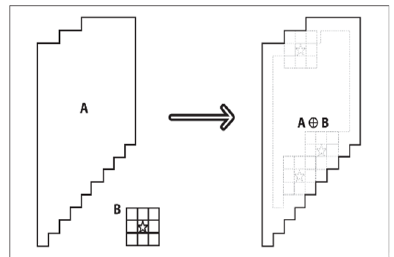
Figure 8. Expansion operation diagram.